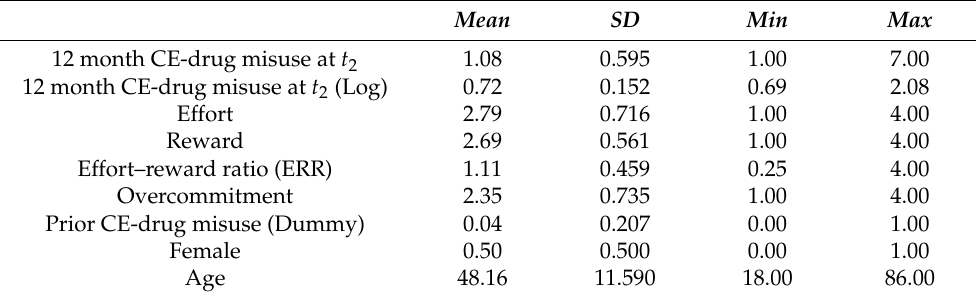
Table 1. Descriptive Information ( N = 11,197) a